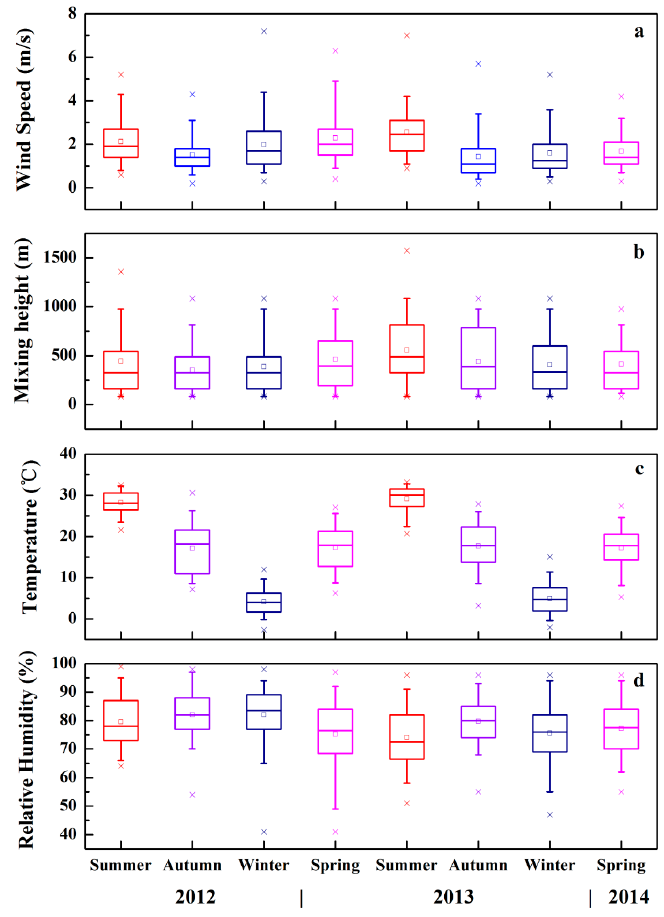
Figure 3. Seasonal variations in wind speed ( a ); mixing layer height ( b ); temperature ( c ); and relative humidity ( d ) in Wuhan during the two-year experiment. The upper and lower edges of the boxes represent the 25th and 75th percentiles; the horizontal line and square in the box show the median and mean values, respectively; the lower and upper whiskers of each box represent the 5th and 95th percentiles, respectively; and the lower and upper crosses represent the 1st and 99th percentiles, respectively.